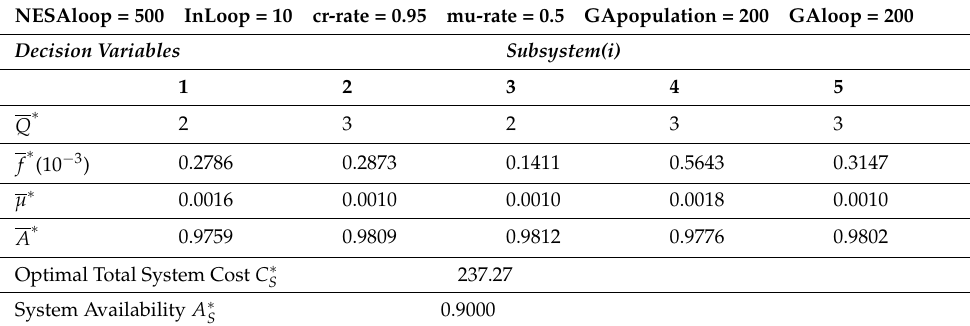
Table 12. Optimal Solutions obtained by NESA–MGA for the n -stage standby